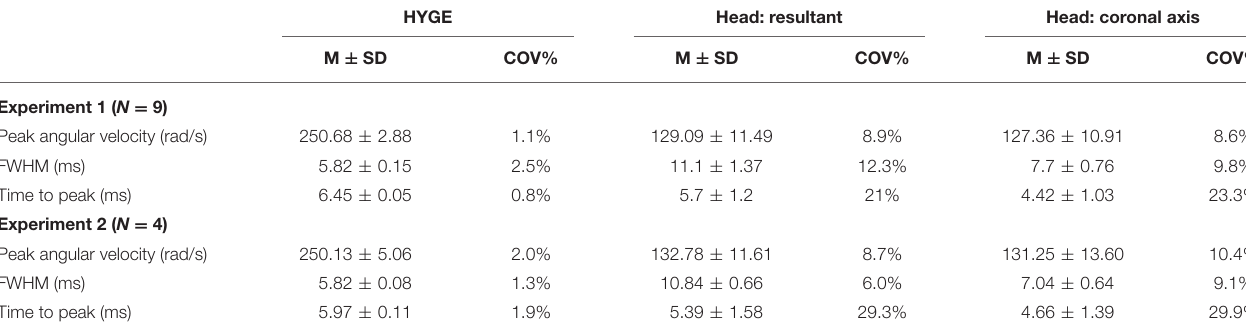
TABLE 2 | Key parameter results for initial testing (experiment 1) and replication (experiment 2) cohorts.